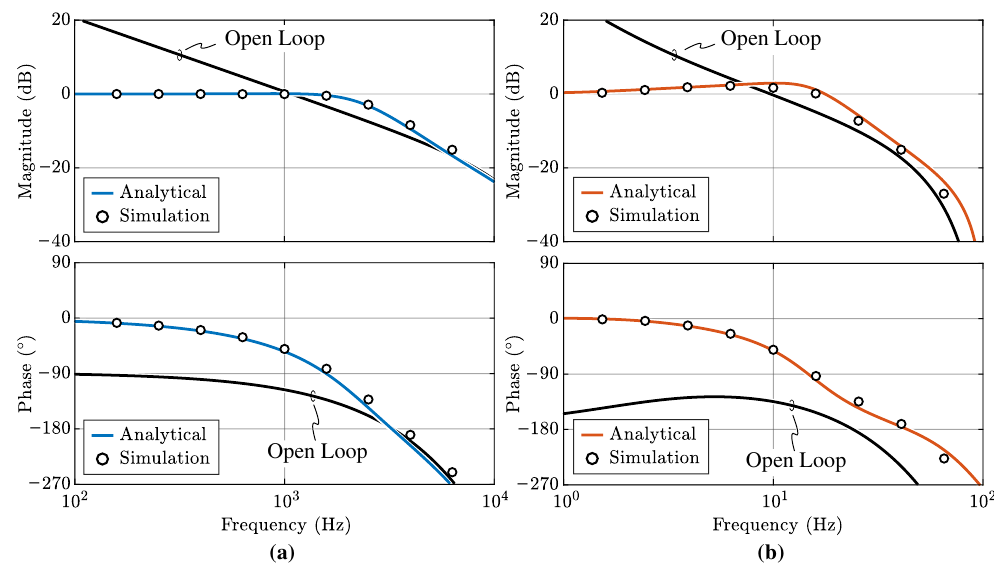
Figure 13. Analytically derived and simulated closed-loop transfer functions of the PFC current controllers ( a ) and DC-link voltage controller ( b ).